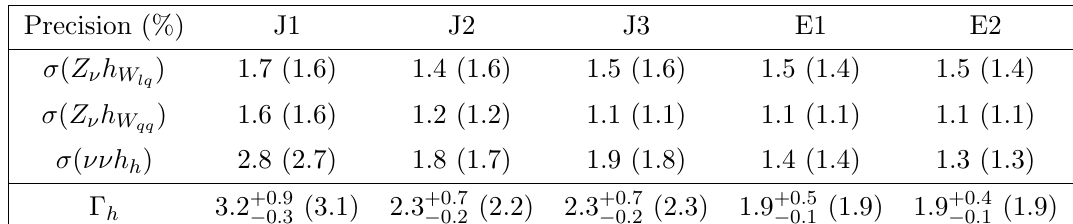
Table 7 . Expected precisions of measuring (cid:0) h with Method B 0 , by applying J1, J2, J3, E1 and E2 classi(cid:12)ers to the data of 5ab (cid:0) 1 @240GeV. In these analyses, the precisions of measuring the inter- mediate quantities (namely, (cid:27) ( Z (cid:23) h W ), (cid:27) ( Z (cid:23) h W ) and (cid:27) ( (cid:23)(cid:23)h h )) are calculated using a likelihood qq lq method based on Poisson statistics (for details on this method, see appendix B), and a precision of 0.5% is assumed for measuring (cid:27) ( Zh ) and 0.3% for measuring (cid:27) ( Zh h ). The numbers in the parentheses represent the performance of these classi(cid:12)ers on the data processed with the FCC-ee IDEA template. The superscripts and subscripts for the numbers in last row denote the maximal changes of precision due to the variance of " from 1.0 to 2.0 and 0.1, respectively.